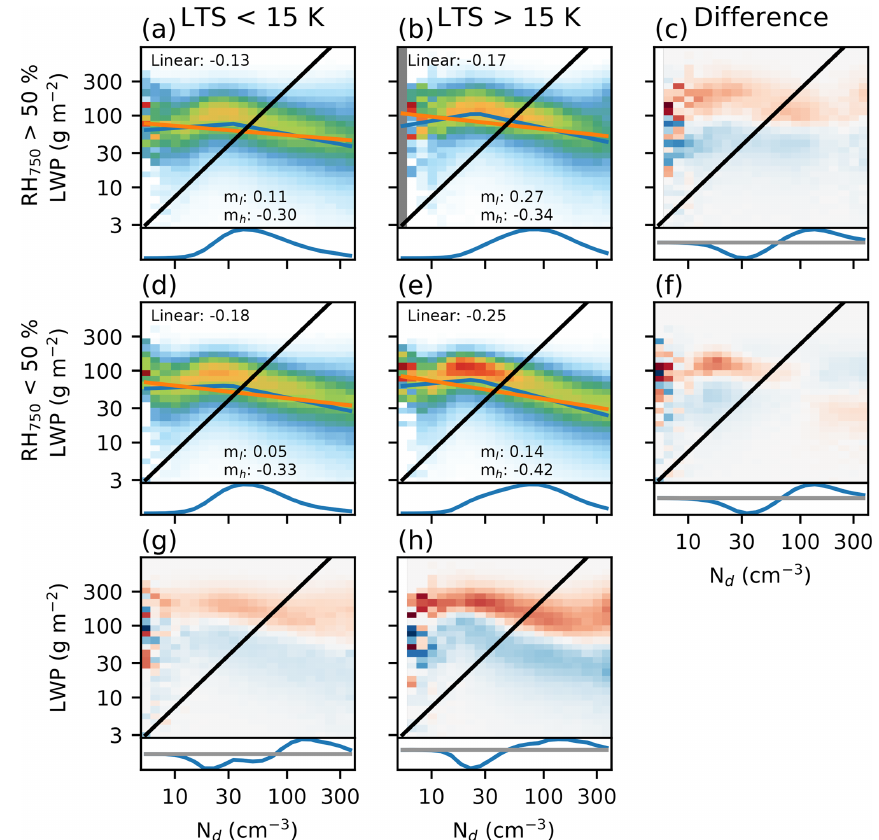
Figure 4. Joint histograms (as in Fig. 2) created for meteorological conditions, separated by RH at 750hPa and LTS. The difference plots are shown at the end of each row and column, with red above blue in each column, showing an increase in AMSR-E in-cloud LWP at high LTS / RH 750 for a given N d . The histograms under each joint histogram show P (N d ) for each set of meteorological